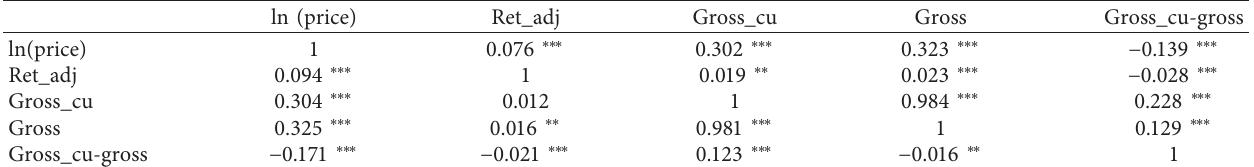
Table 3: Correlation analysis of main variables. Definition of variables is given in Table